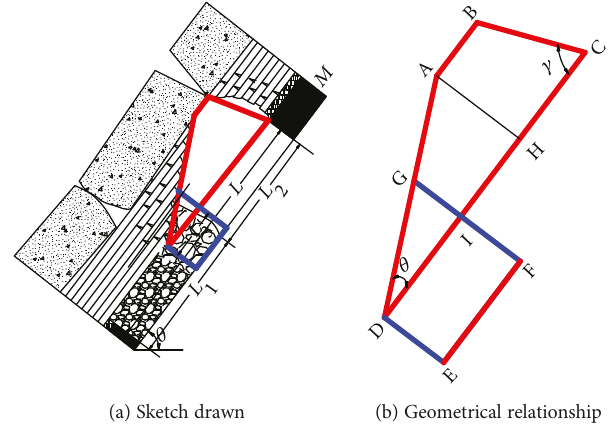
Figure 3: Sketch of roof caving and the back fi ll in the goaf.